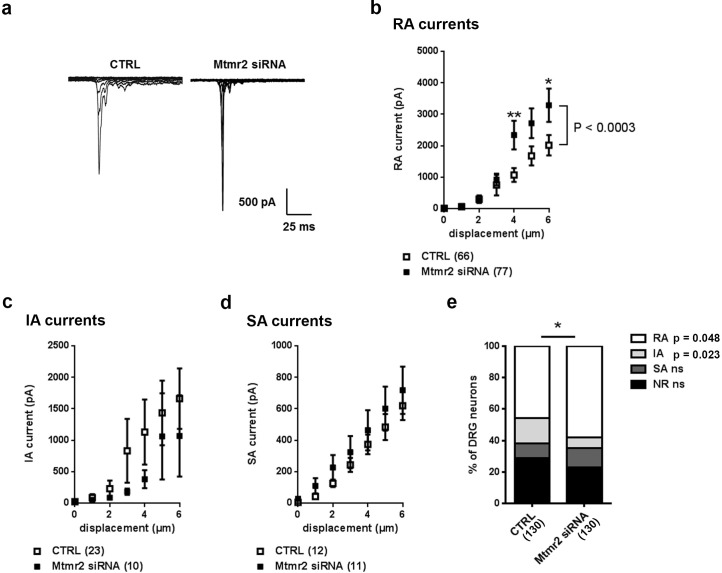
Mtmr2 knockdown potentiates Piezo2 activity in peripheral sensory neurons.(a) Representative traces of RA-MA currents in primary cultures of DRG neurons and (b) stimulus-current curves for RA-MA currents upon nucleofection of Mtmr2 siRNA showed a significant increase in RA-MA current magnitude compared to nucleofection with AllStar Negative Control siRNA (CTRL: n = 66 neurons; Mtmr2 siRNA: n = 77 neurons; 2-way ANOVA suggested a pronounced effect (P<0.0003) of Mtmr2 knockdown on RA-MA currents; Holm-Sidak’s multiple comparisons test was used to compare both conditions at individual stimulus magnitudes, p-values are indicated by * in the graph). The displacement threshold and inactivation time constant of RA-MA currents remained unchanged upon knockdown of Mtmr2 (Supplementary file 1). Of note, MA current properties cannot be compared between different experiments or treatments of DRG cultures, for example Figure 2b cannot be compared to overexpression of Mtmr2 (Figure 1). Cultures were differently nucleofected (siRNA vs. plasmids) and recorded on different days in vitro (DIV) according to established protocols (please see Materials and methods for details). Hence matching controls were performed for each set of data. (c) Stimulus-current curves show IA-MA currents were unaffected by knockdown of Mtmr2 in DRG neurons (CTRL: n = 23 neurons; Mtmr2 siRNA: n = 10 neurons; ns; 2-way ANOVA). (d) Stimulus-current curves show SA-MA currents were unchanged upon Mtmr2 knockdown (n = 11–12 neurons per condition; ns; 2-way ANOVA). Of note, the displacement thresholds and inactivation time constants of IA-MA and SA-MA currents remained unchanged upon Mtmr2 siRNA nucleofection (Supplementary file 1). (e) Stacked histograms show the number of cells exhibiting different MA currents upon knockdown of Mtmr2 in cultured DRG. The proportions of cells exhibiting RA and IA currents were significantly changed in cultures transfected with Mtmr2 siRNA. RA:IA:SA:NR (% of total; rounded to whole numbers): CTRL: 46:16:9:29; Mtmr2 siRNA: 58:7:12:23; p<0.044 overall and for the proportion of RA/total (p=0.048) and IA/total (p=0.023), respectively; Chi-square test;≥130 neurons were analyzed per condition). NR (non-responsive), refers to cells which showed no MA current.